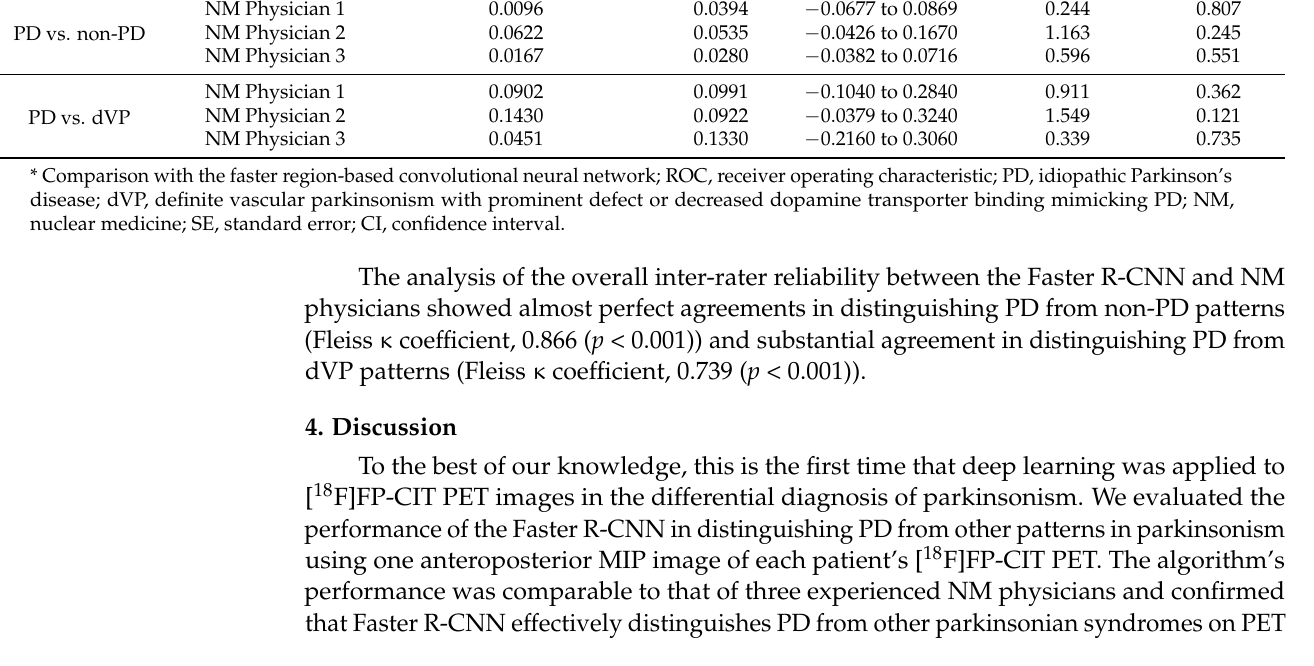
network and nuclear medicine physicians based on image patterns.